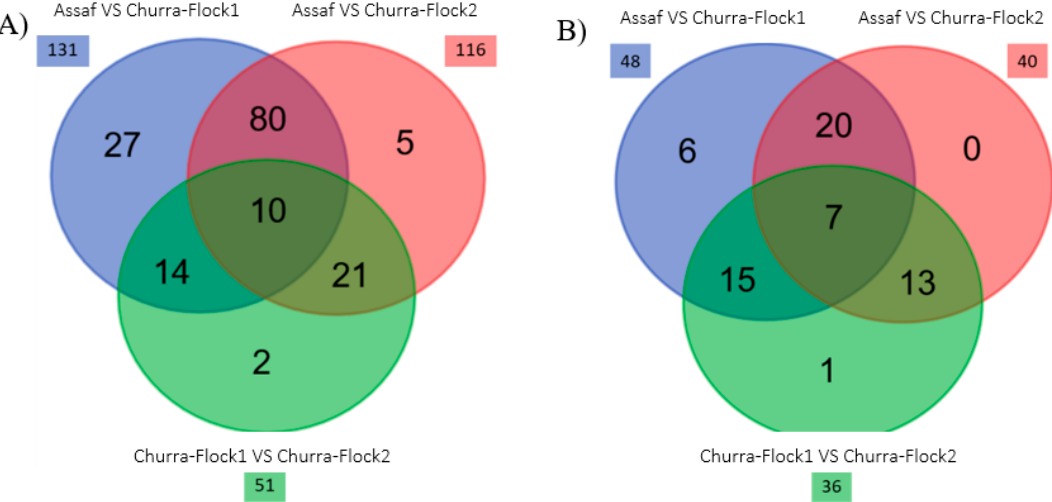
Figure 4. Differentially abundant genera (DAG) across the different flocks. ( A ) Venn diagram classifying all DAG reported by the DADA2 implemented pipeline. ( B ) Venn diagram classifying only DAG showing a relative abundance higher than 0.1%. Venn diagrams showing the relations between the DAG in the pairwise comparison of the considered subsets: Assaf versus Churra-Flock1 (blue), Assaf versus Churra-Flock2 (red), and Churra-Flock1 versus Churra-Flock2 (green). DAG were filtered with a threshold adjusted p -value ≤ 0.05 and an absolute log2 fold-change of ≥ 1.5. The total number of DAG for the different pairwise comparisons are indicated with an external square to the Venn diagram. The 20 common shared microbiota in the pairwise comparisons between the Assaf-VS-Churra- Flock1 and Assaf-VS-Churra-Flock2 might be considered as breed-specific genera. From those, we Mean log2FC lfcSE Stat p -Value p -Adj Table 3. Details of the differential abundance analysis for the four DAG commonly identified between the Assaf vs. Churra-Flock1 and Assaf vs. Flock2 contrasts and that were included in the list of 10 top- most abundant taxa (Table 2) ( p -adj < 0.05 | log2foldChange > 1.5). Pairwiswe Base Genus Comparations Assaf vs.